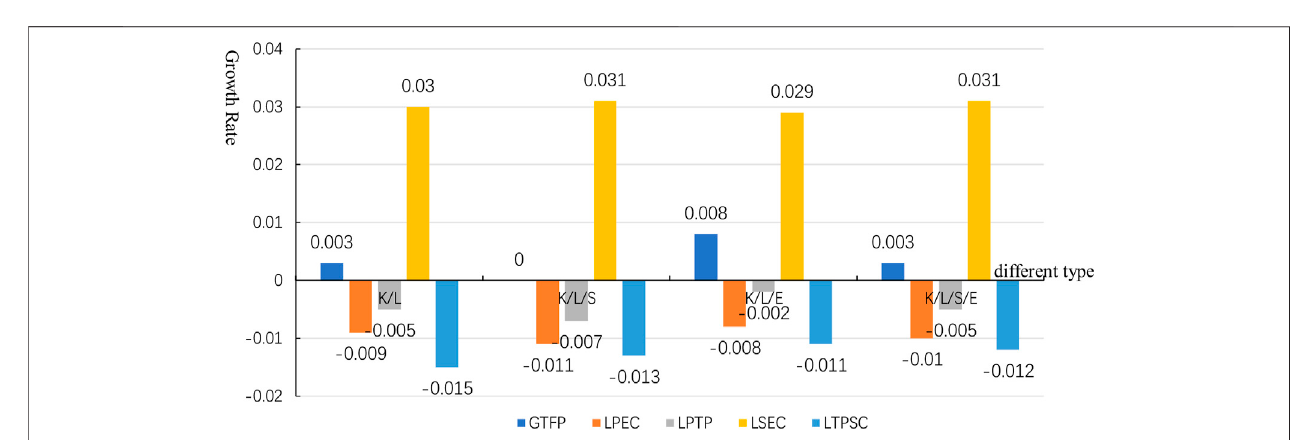
FIGURE 3 | Growth rate and decomposition results of overall GTFP in four cases (K/L; K/L/S; K/L/E; K/L/S/E).